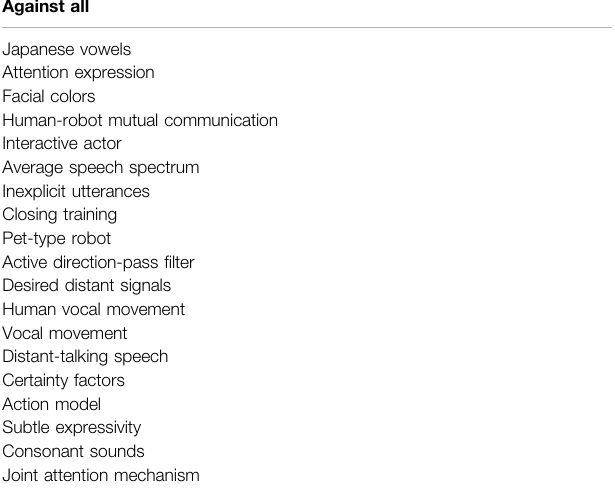
TABLE 3 | Contrastive analysis: range 2010 – 2014. Against all